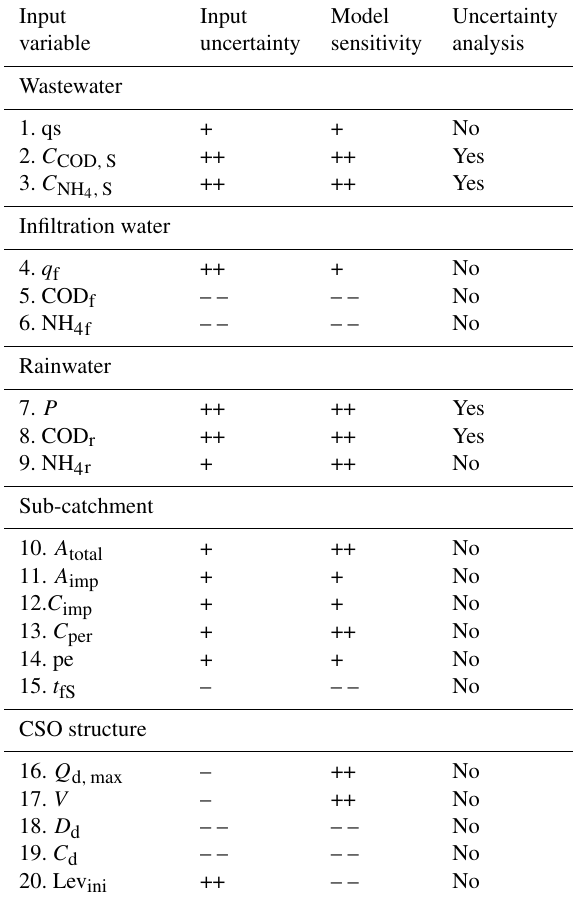
Table 2. Input variables of the EmiStat R model and selection of inputs for uncertainty analysis based on input uncertainty level and model sensitivity level (Note: ++ is very uncertain/sensitive; – – is not